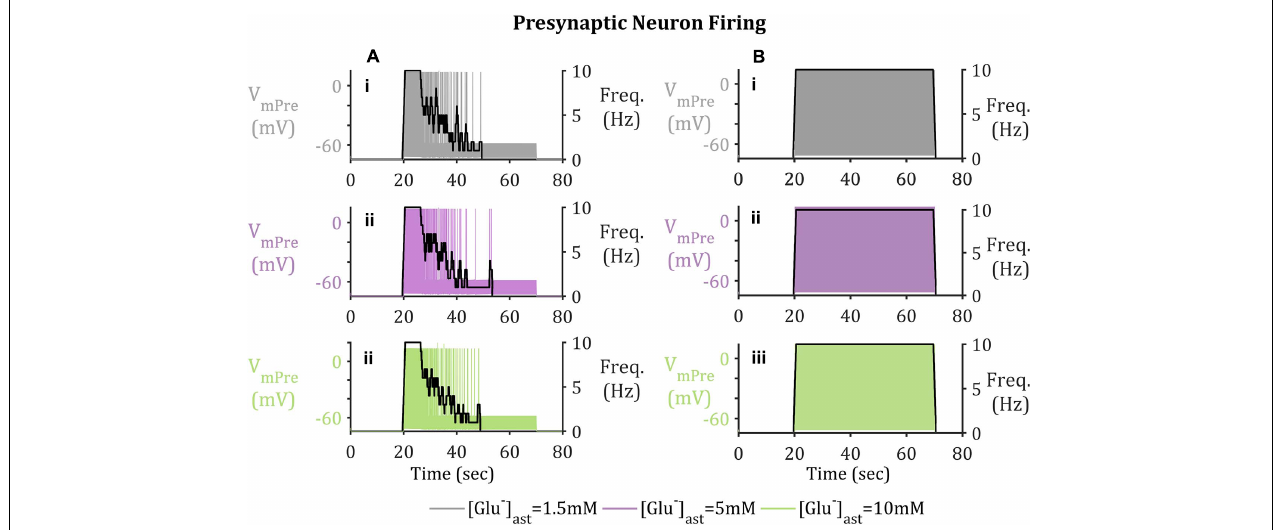
FIGURE 5 | Presynaptic Neuron Membrane Activity (A) with and (B) without GAT-3-mediated GABA release. Upon activation of the presynaptic neuron by means of a pulsed applied current, Glu released into the synapse triggers the activation of EAAT-2 currents, located on the astrocytic membrane. EAAT-2 transports both Glu and Na + into the astrocyte disturbing the equilibrium state of GAT-3, resulting in the release of GABA back to the presynaptic neuron, where upon binding to presynaptic membrane-bound GABA A -Rs inhibits the neuron, even in the presence of a pulsed applied current. (i–iii) shows presynaptic neuron membrane potential, overlaid with presynaptic neuron firing frequency (given in black with the right-hand y-axis). Results describe basal (i) [Glu] ast = 1.5 mM, ( ii ) [Glu] ast = 5 mM, and (iii) [Glu] ast = 10 mM.